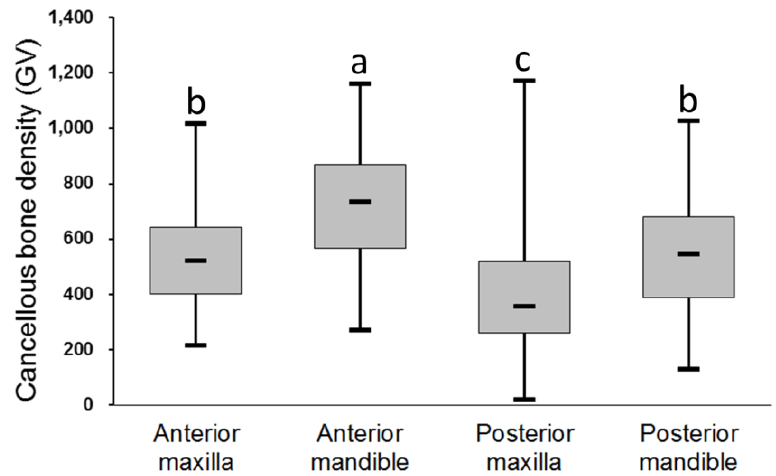
Figure 3. Cancellous bone density at dental implant sites in different regions of the jawbone. Post hoc pairwise comparisons were conducted using Scheffe’s test; use of the same letter indicates no significant difference at the 0.05 level.